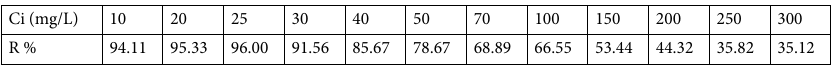
Table 3. Effect of initial dye Cibacron blue P-R3 (CB) concentration on the removal efficienty [m (Bb) = 3.6 g/L; pH = 2.2; ω = 250 tr/min; T = 25 °C; t = 2 h].